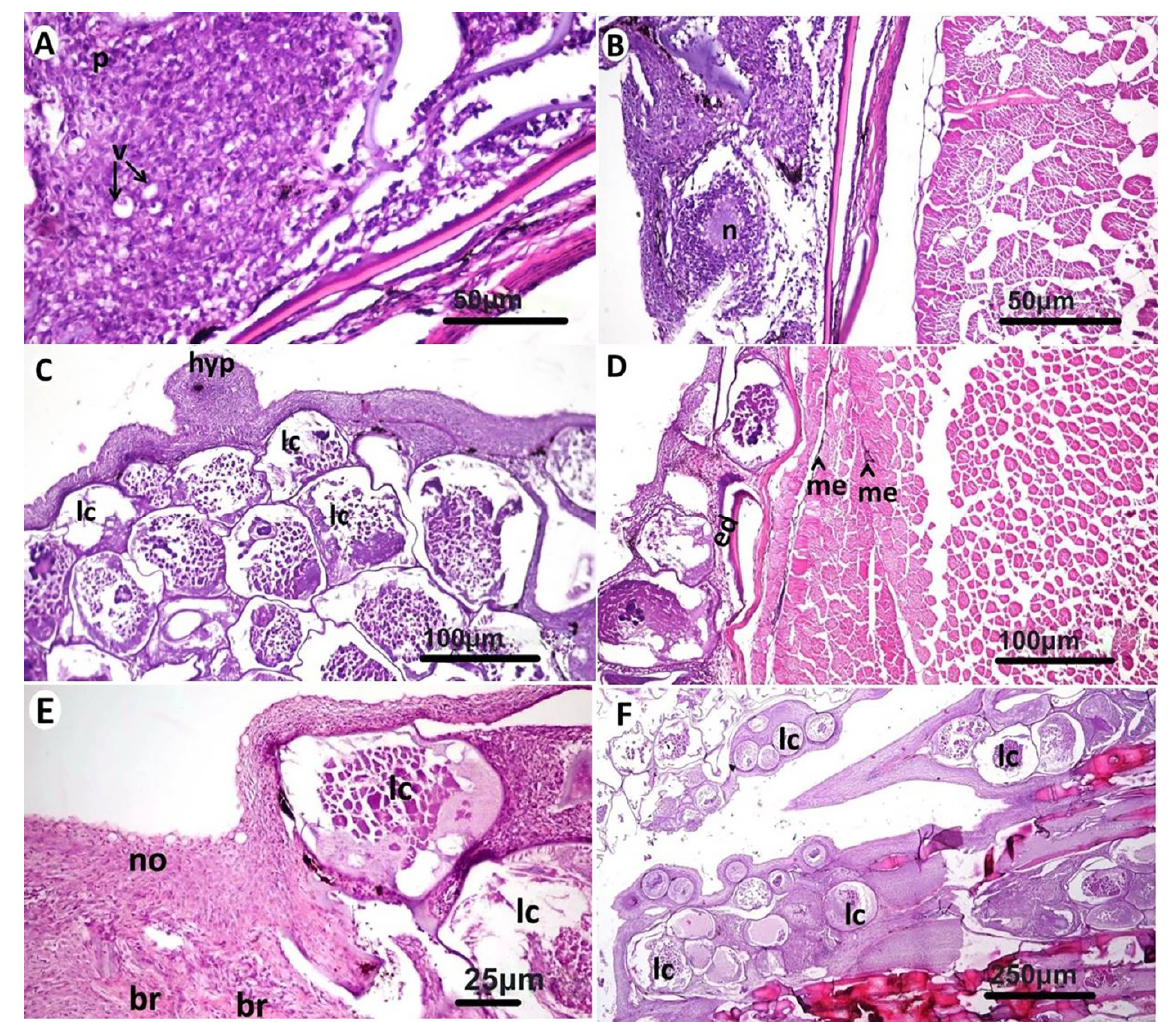
Figure 3. Microscopic pathological examination of affected gilthead seabream ( Sparus aurata ) fins. ( A ): Epidermal layer showing vacuolar degeneration (v) and pyknotic nuclei (p). ( B ): Melanin pigment aggregation and necrosis (n) in the epidermis. ( C ): Nodular epidermal hyperplastic proliferation (hyp) and multiple lymphocystis cells (lc). ( D ): Edema in scale pocket (ed) and few melanophores aggregated (me) in the underlying musculature. ( E ): Lymphocystis cells (lc) in fins adjacent to bony rays (br) beside apparently normal (no) fin tissue. ( F ): Multiple lymphocystis cells (lc) of variable sizes in the fins. (H&E).